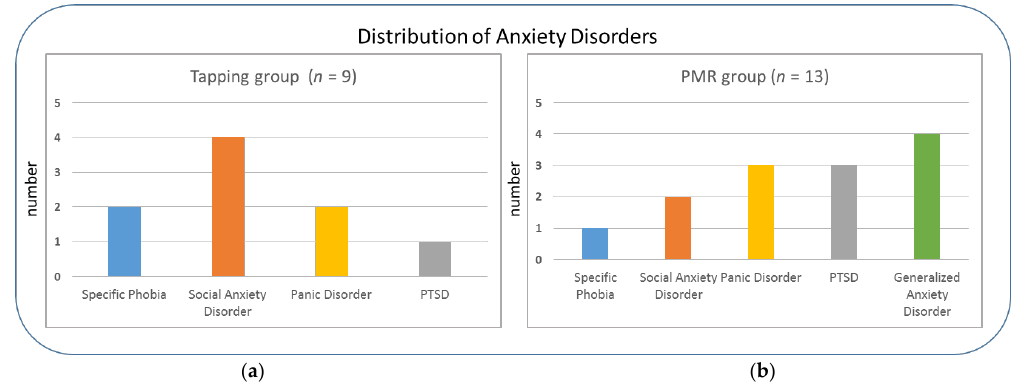
Figure 1. Main diagnoses of anxiety patients in the two intervention groups: ( a ) Tapping and ( b ) Progressive Muscle Relaxation (PMR); Post Traumatic Stress Disorder (PTSD).